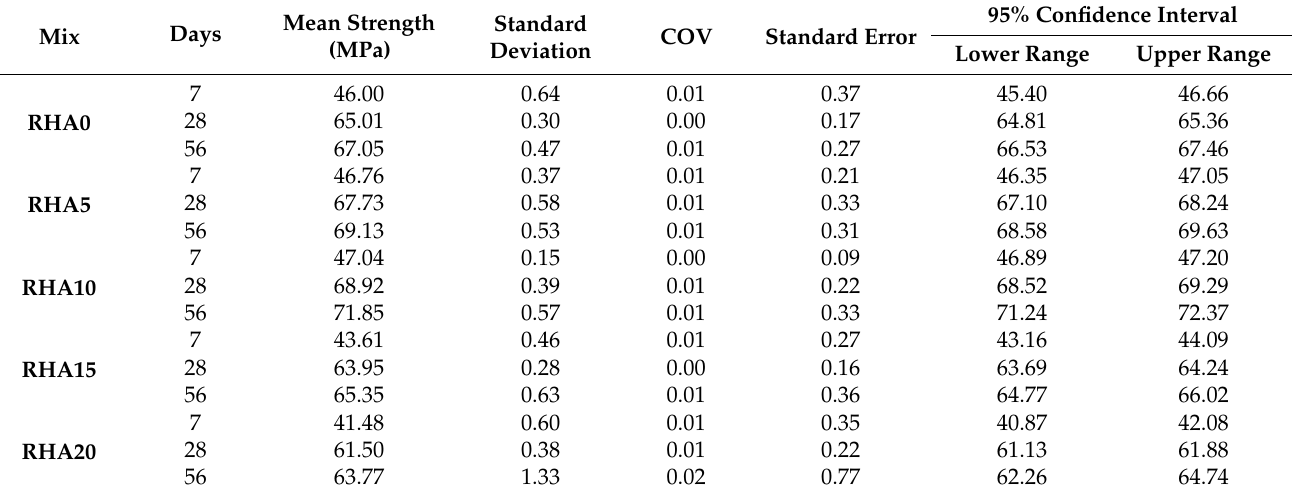
Table 4. Summary of the compressive strength test outcomes.